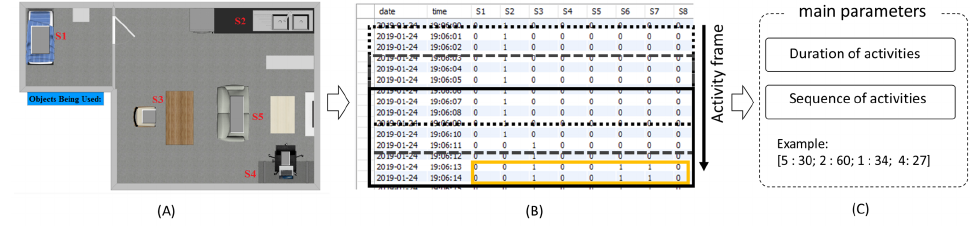
Figure 5. ALL data collection overview; ( A ) ALL environment layout. S1-S5 are each spaces,